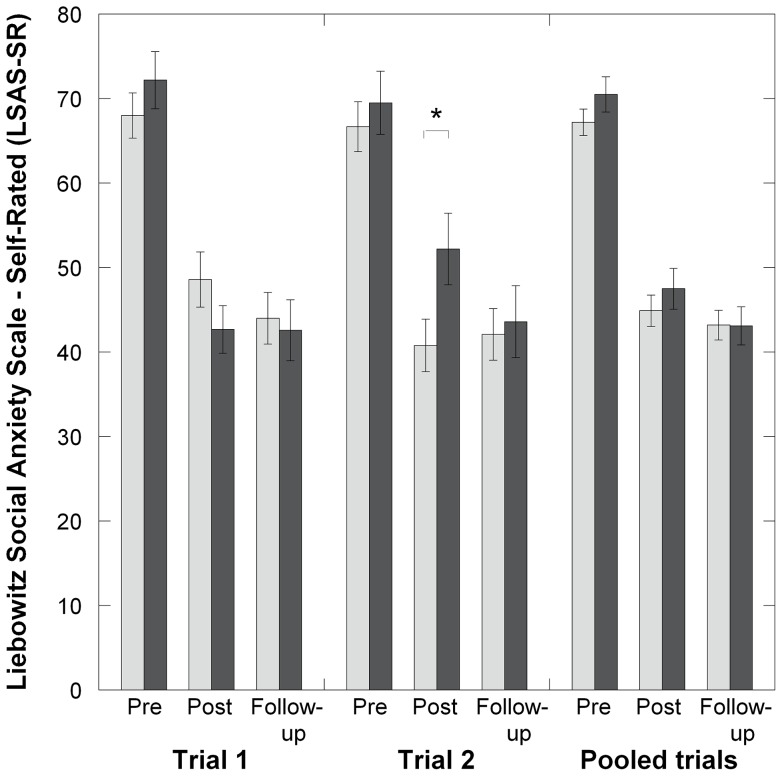
Liebowitz Social Anxiety Scale self-rated score (LSAS-SR) by TPH2 G-703T genotype before and after cognitive behavior therapy (CBT) in social anxiety disorder (SAD) patients.Mean LSAS-SR score in G homozygotes (light grey bars) and T carriers (dark grey bars).